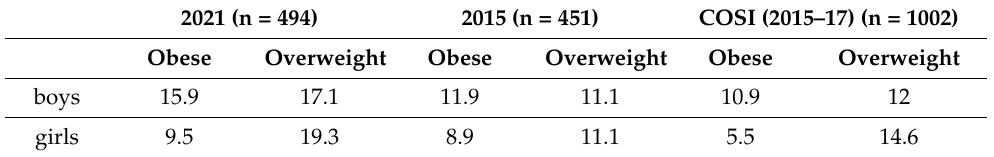
Figure A2. Prevalence of overweight, obese, and severely obese girls in 2019. Table A2. Comparison of data of 7-year-olds from our study with results of WHO project COSI 2021 (n = 494) [30]. Obese Overweight Obese Overweight Obese